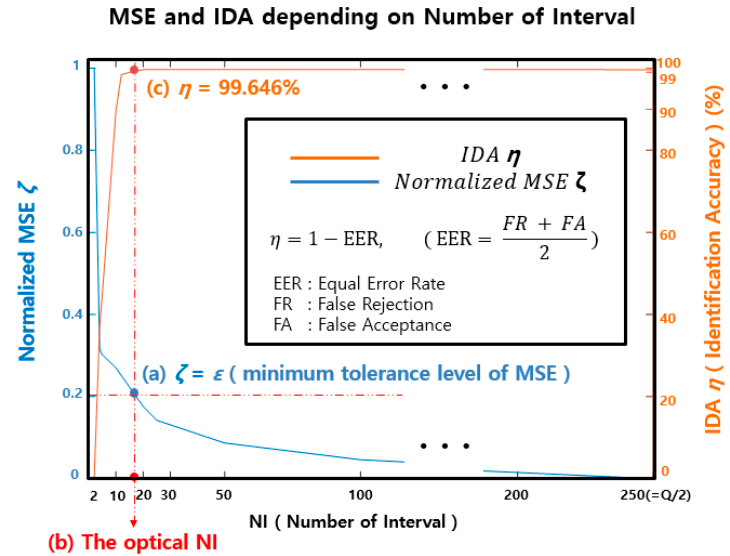
Figure 7. The relationship between the MSE (Mean Squared Error) ζ and the IDA (Identification Accuracy) η according to NI (Number of Interval) values to show the decision of the optimal NI. In this experiment, the optimal NI is set as the value when η = 99.646% and ζ = ε